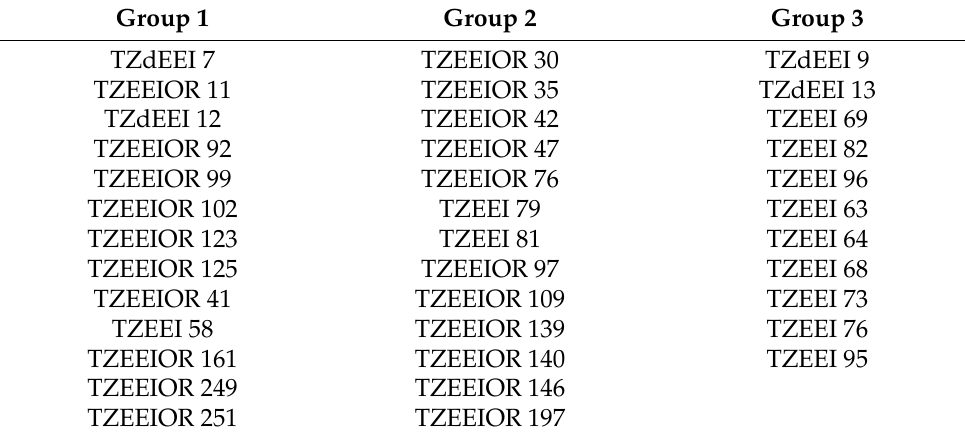
Table 6. Heterotic groups of 33 provitamin A inbred lines and four testers across contrasting environ- ments in Nigeria, 2014–2016, using the HGCAMT grouping